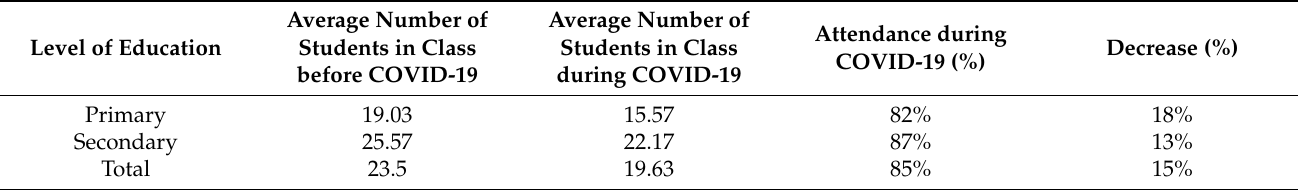
Table 5. The average number of students participating in the class before the beginning of the pandemic and the average number of students participating in the class during the pandemic (question 3 and question 4).